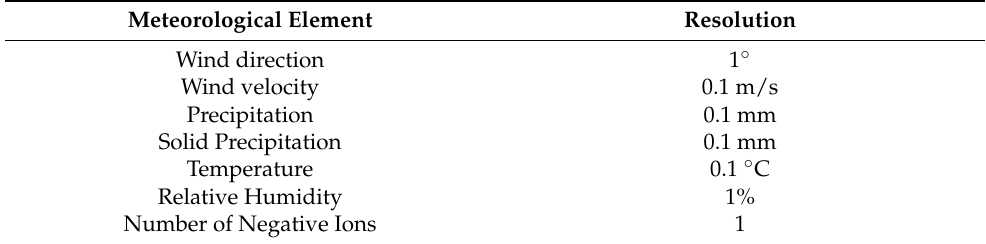
Table 3. Meteorological elements and their resolution of the multi-function stations.